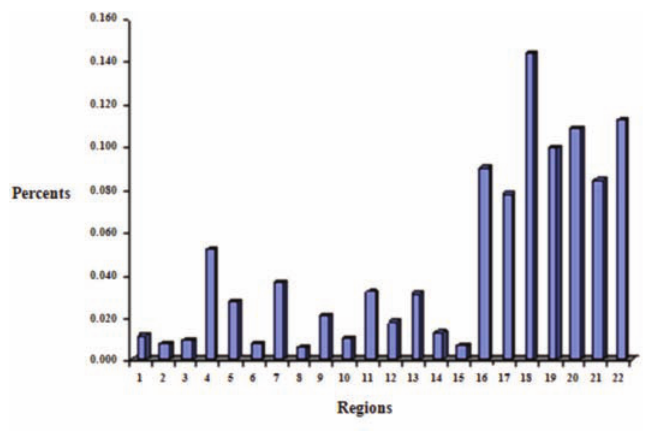
Figure 5. The percentage of occurrences in each region, with the zoning by K94 [from Sadeghian and Jalali-Naini 2008b].